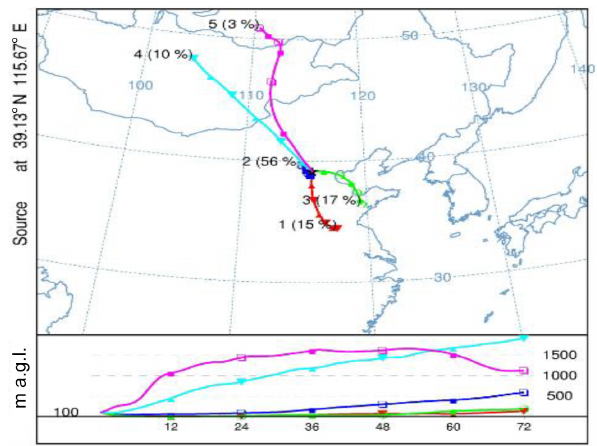
Figure 12. The 72h backward trajectories for 100m above ground level at Gucheng during the sampling period in